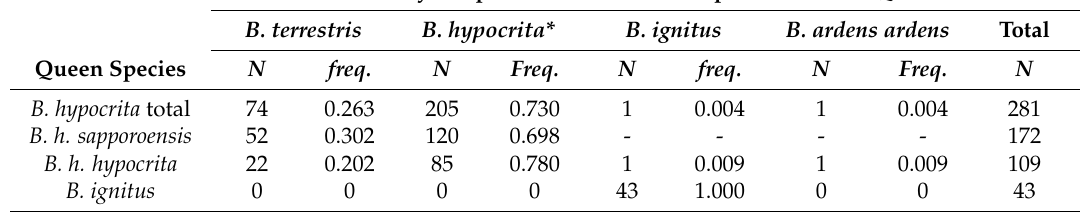
Table 3. The results of sequence analysis for spermatozoa stored in the spermathecae of Japanese native